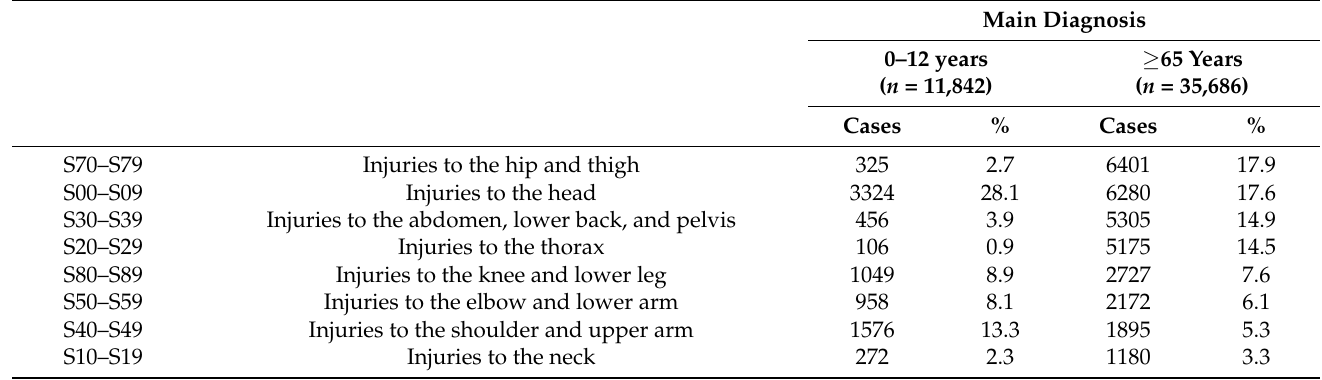
Table 3. Main diagnosis codes in children and elderly patients with